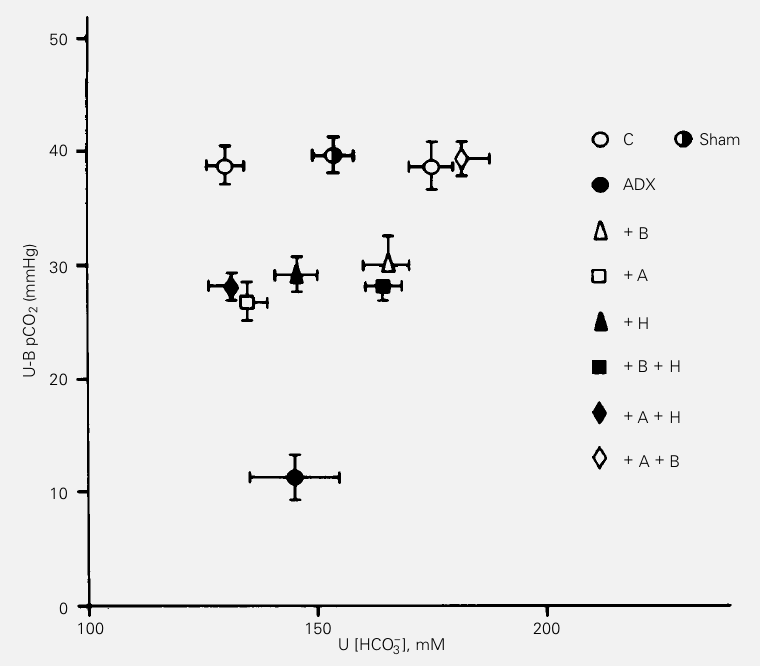
Figure 4 - U-B pCO 2 plotted against urine bicarbonate concentrations under different experimental conditions. Data are reported as means – SEM. Symbols as in Figure 1, except H = 18-OH corticosterone. From Ref. 27, with